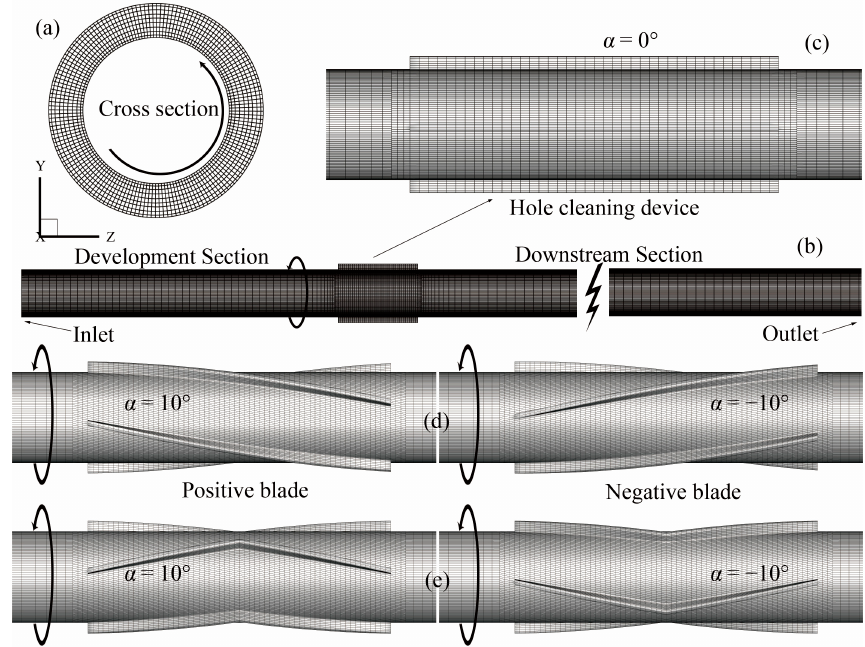
Figure 2. The mesh structures of the hole cleaning device: ( a ) cross section, ( b ) the whole system, ( c ) helical angle at α = 0°, ( d ) positive and negative blade of the straight blade, and ( e ) positive and negative blade of the V-shaped blade.